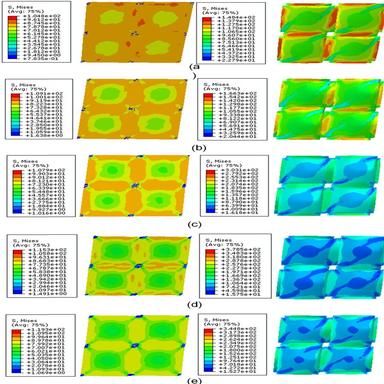
Mises stress contour of the yarn and the matrix with different defect content: (a) FE_C; (b) FE_CD 1; (c) FE_CD 2; (d) FE_CD 3; (e) FE_CD 4.